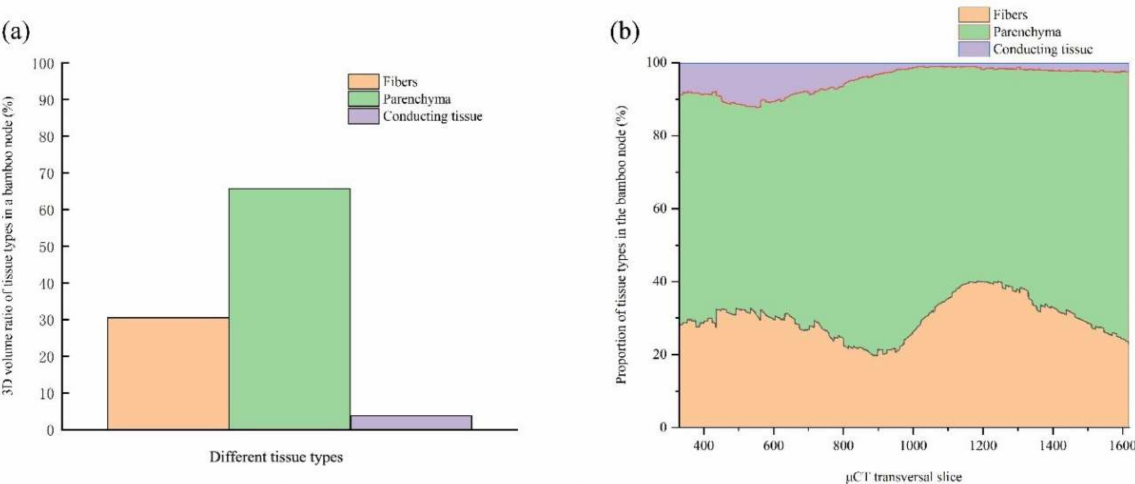
Figure 7. Tissue proportion of the bamboo node. ( a ) Proportions of different tissues in the node. ( b ) Distributions of tissue proportions in the